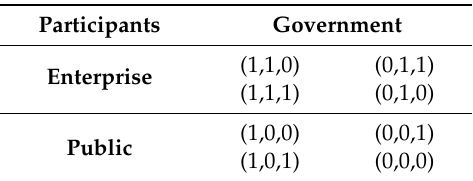
Table 3. Equilibrium